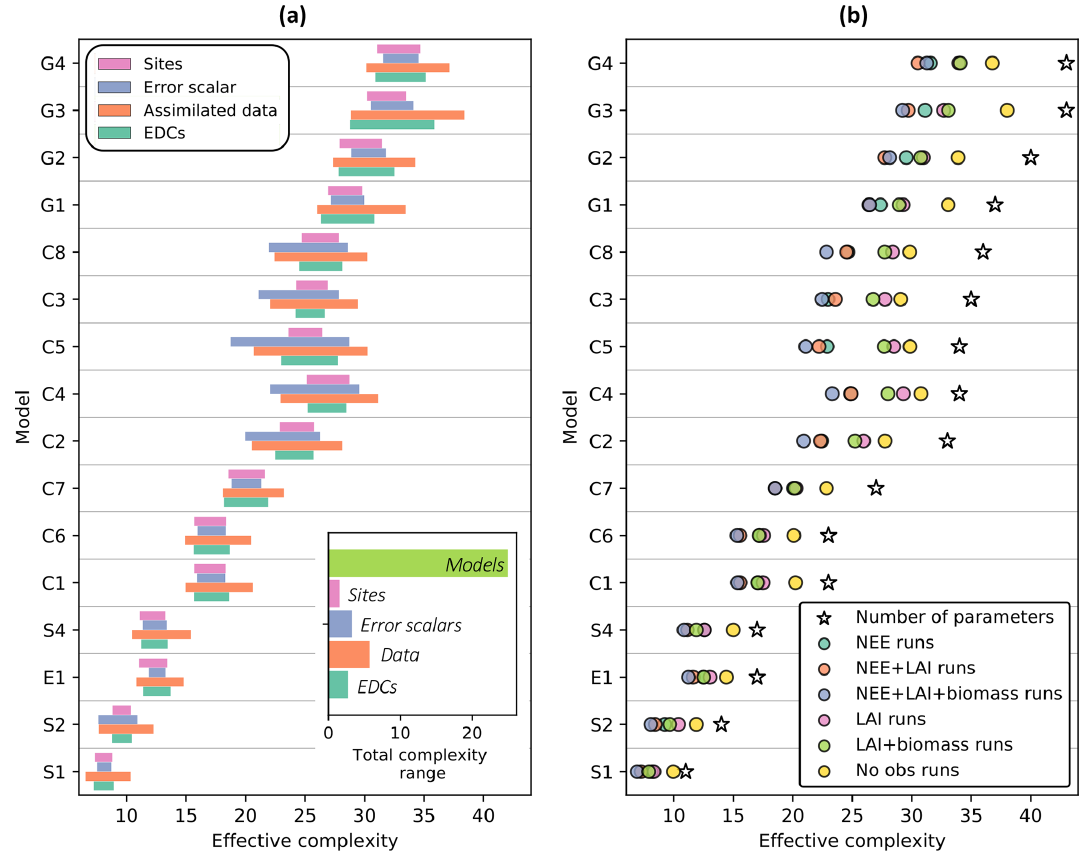
Figure 4. Influence of the experimentally varied factors on effective complexity. (a) Range of effective complexity attributable to sites, error scalars, assimilated data, and EDCs for each model (row). Inset: range of attributed effective complexity across all model runs. (b) Average effect of assimilated data combination on effective complexity for each model. Colored circles are means of corresponding runs. Models are ordered from fewest (S1) to greatest (G4) number of parameters. See Table 1 for definition of model